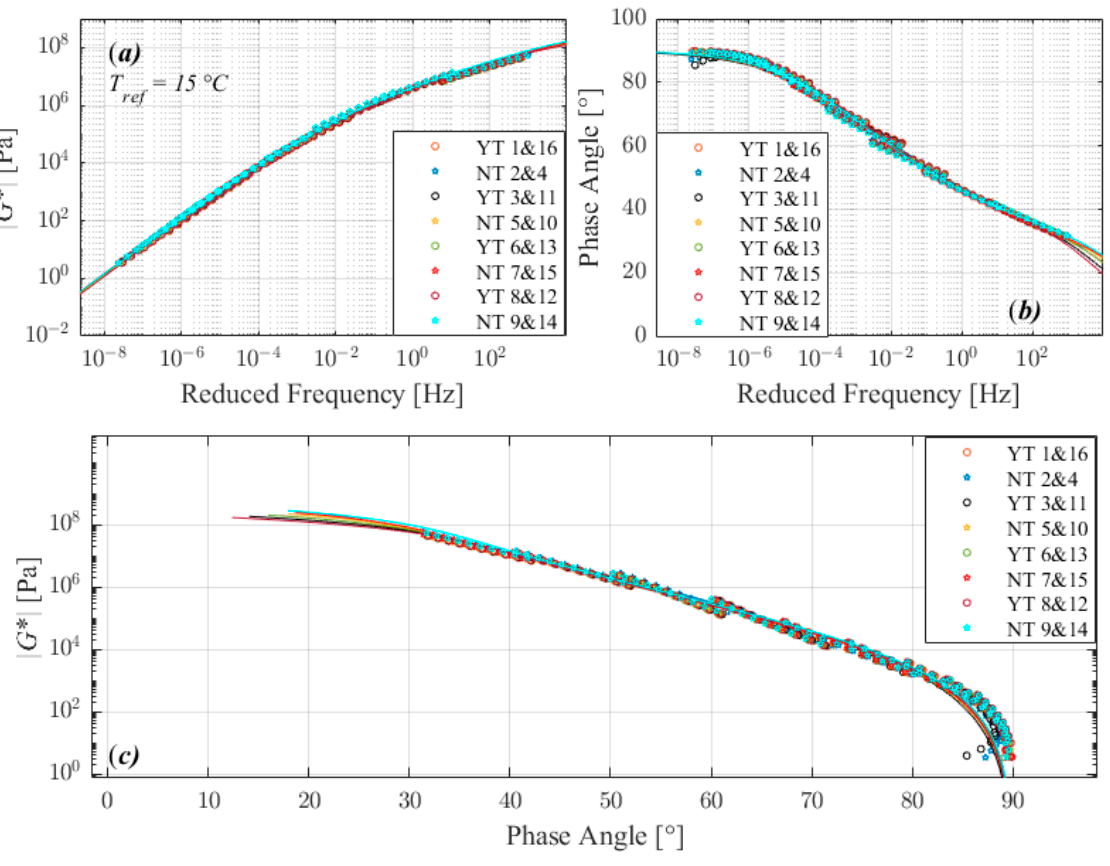
Figure 3. Comparison of master curves of complex shear modulus ( a ), phase angle ( b ), and black diagram ( c ) for 50/70.